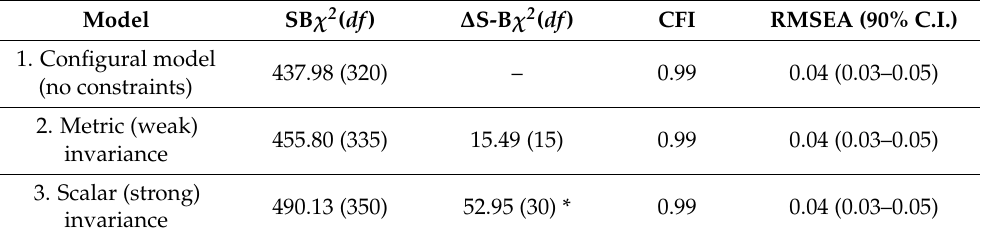
Table 3. Tests for invariance of the SUPPS-P goodness of fit statistics.